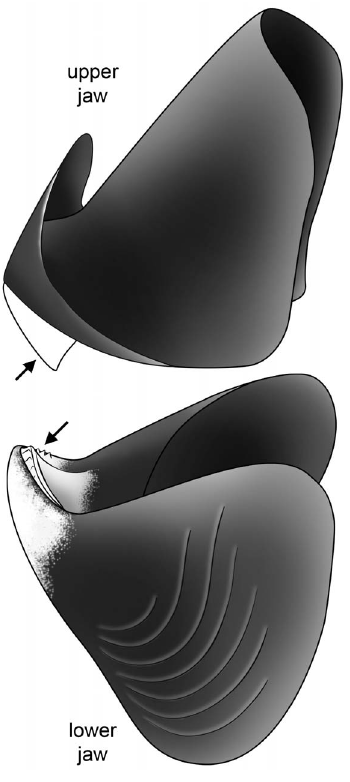
Figure 1. Lateral view of the upper and lower jaws of Nautilus pompilius . Calcitic structures are represented in white, while the main chitinous part of the jaws is displayed in black. Arrows indicate where samples were taken for isotopic analyses.